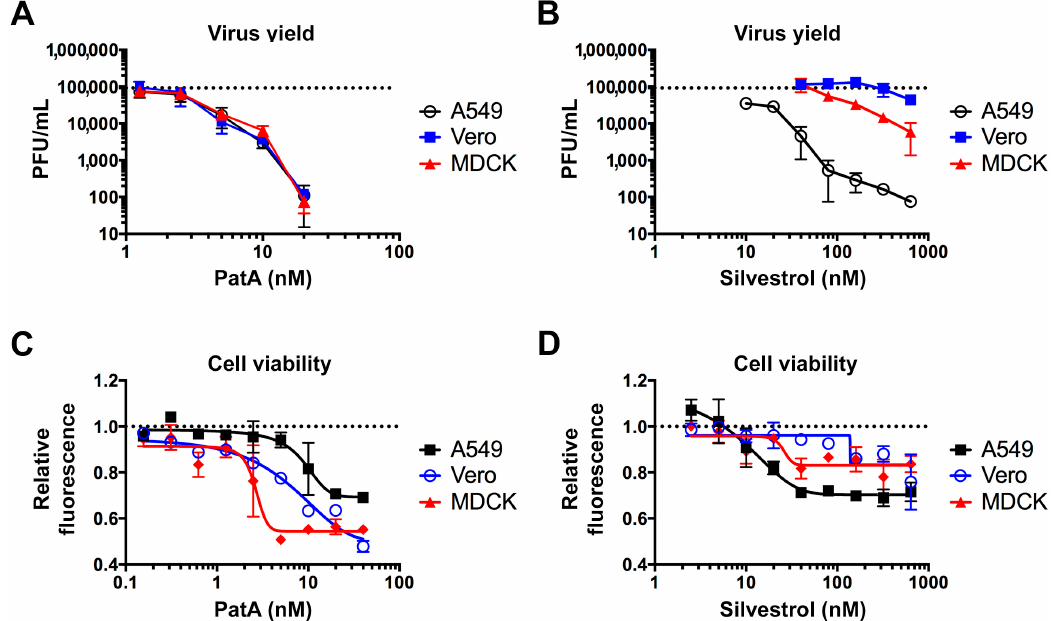
Figure 2. Antiviral and cytotoxic effects of pateamine A and silvestrol vary between cell types. ( A , B ) Production of infectious virus progeny (PR8 strain) at 24 hpi was measured using plaque assay. The indicated cell lines were infected with multiplicity of infection (MOI) = 0.1 and treated with the increasing concentrations of pateamine A ( A ) or silvestrol ( B ) at 1 hpi. Dotted horizontal lines in A and B indicate the average PFU/mL of untreated cells. ( C , D ) Cell viability was measured using Alamar Blue assay after 24-h treatment with increasing concentrations of pateamine A ( C ) or silvestrol ( D ). Relative fluorescence values are normalized to vehicle control (DMSO). All error bars represent standard deviations from 3 independent biological replicates. Dotted horizontal lines in ( C , D ) indicate the relative fluorescence of untreated cells.